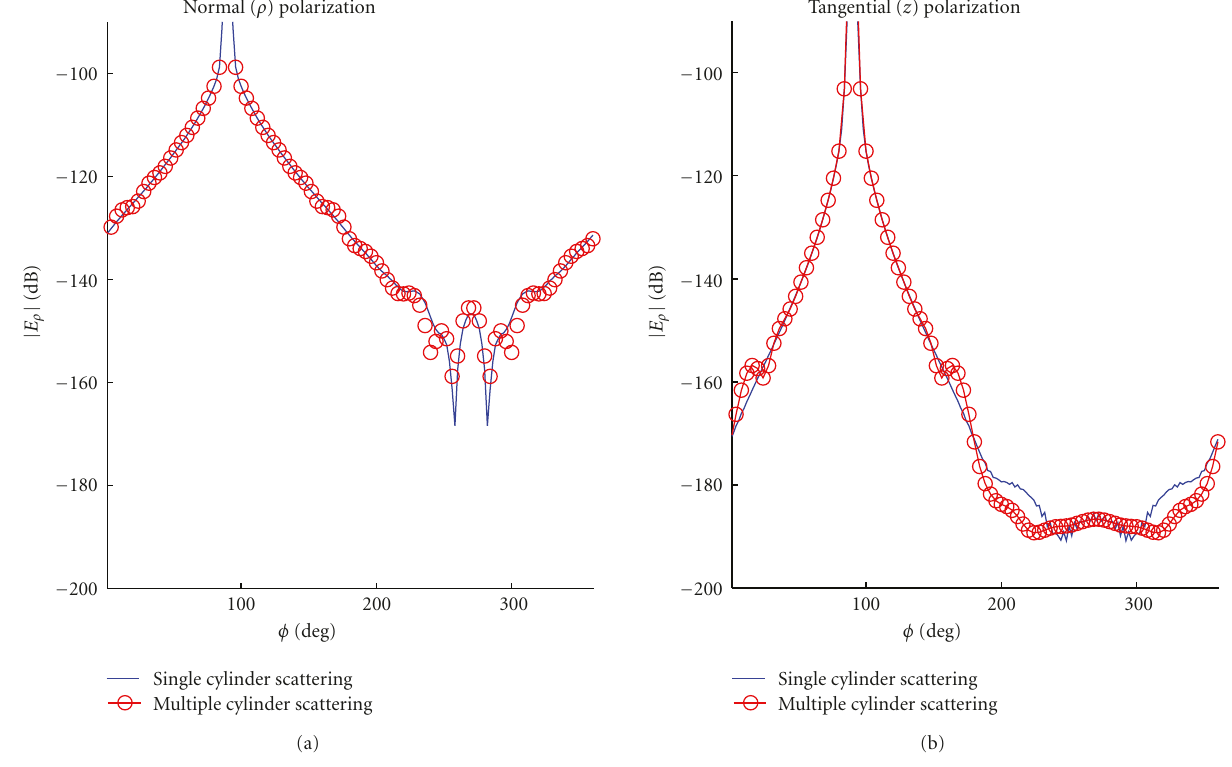
Figure 4: Simulation comparison of the field amplitude (dB) between single cylinder scattering and multiple cylinder scattering of a point source with I = 10 − 10 A in z and ρ polarizations at 2.45GHz around the trunk ( r body = 15 . 4cm, r arm = 3 . 5cm, d ab = 3 . 5cm, d s = 1cm). The source is placed at ρ s = 15cm, φ s = 90 ◦ and the fields are computed at ρ = 15 cm, φ = [0 − 360] ◦